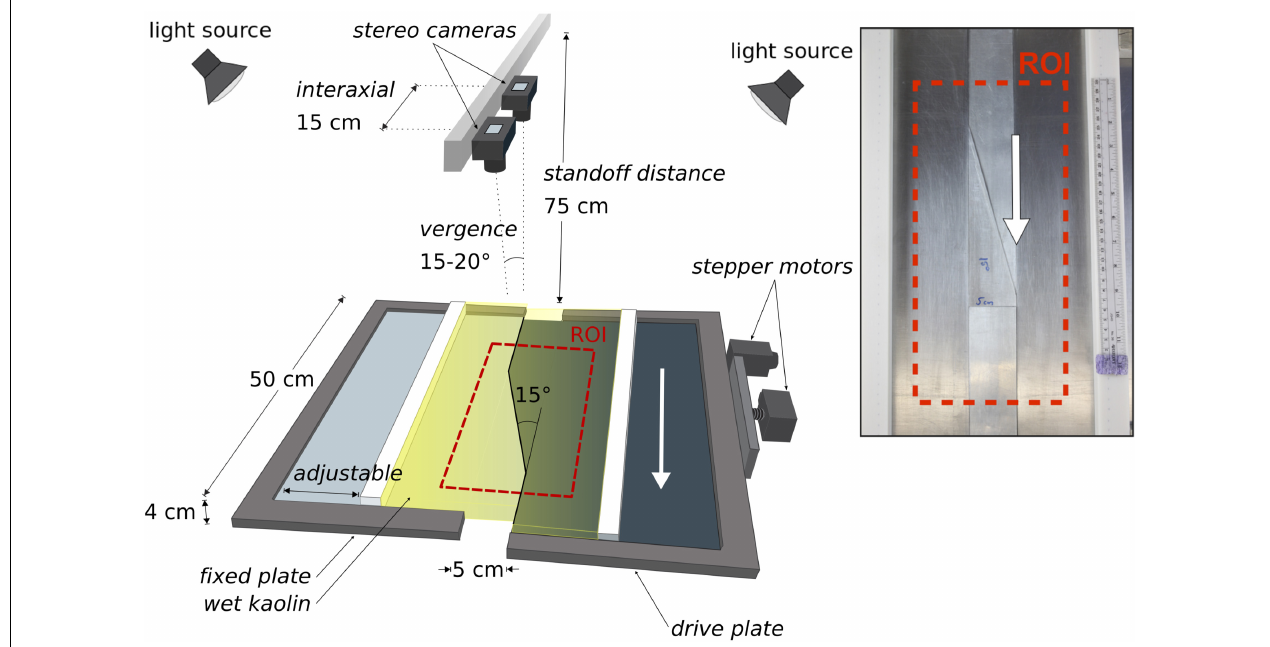
FIGURE 2 | Setup for the experiment that simulates the Mount McKinley restraining bend. (Inset) Basal steel plates fitted with triangular aluminum inserts (15 ◦ , 5 cm wide) drive the overlying wet kaolin clay with right-lateral displacement. The triangular restraining segment is attached to the fixed plate and overlaps the driving plate. The red dashed box indicates the fixed region of interest (ROI) for image